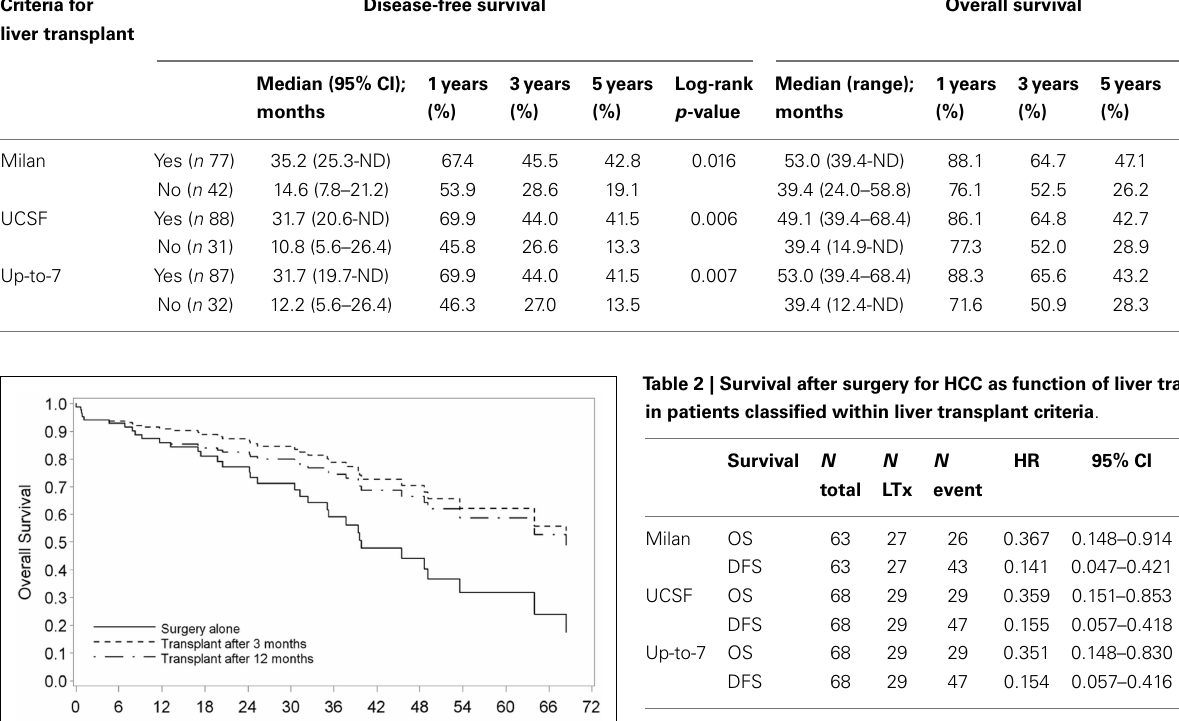
Table 1 | Survival after surgery for HCC in patients as classified according to criteria for liver transplant . Criteria for